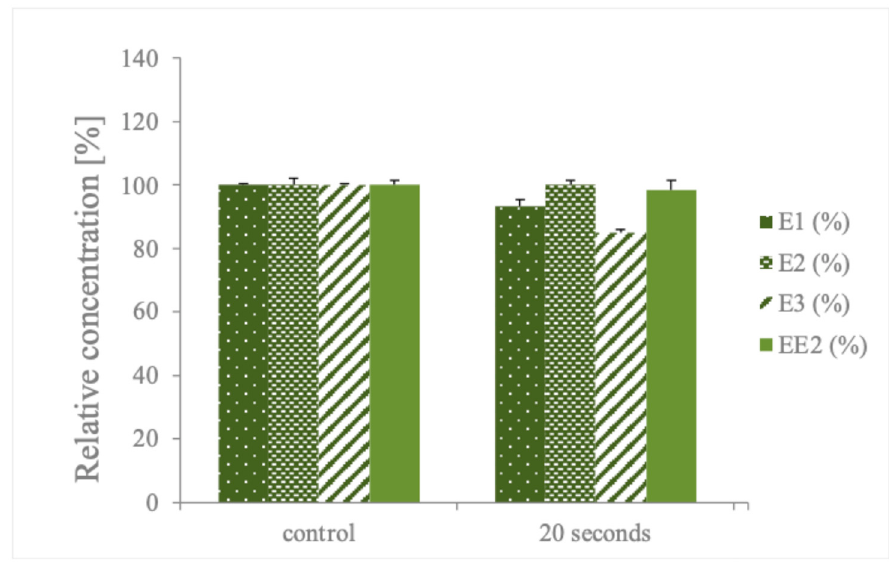
Figure 5. Relative concentration of estrogens after treatment with HC only.